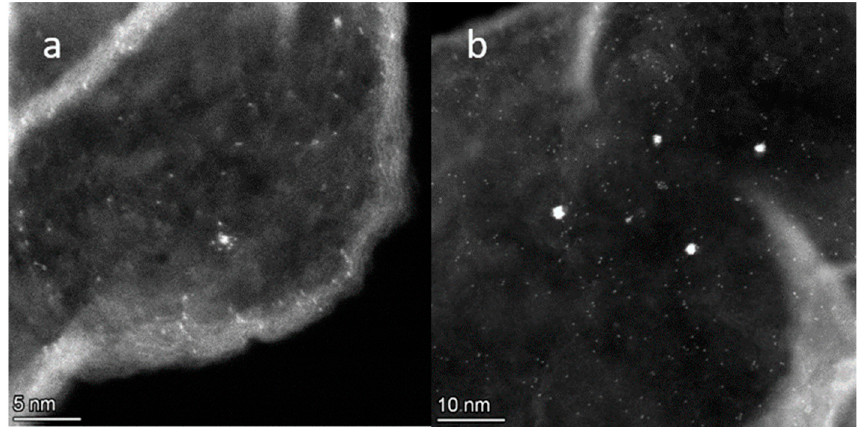
Figure 4. HAADF STEM images of 0.4% ( a ) and 1% Pt/N-graphene (H 2 PtCl 6 ) ( b ) catalysts.